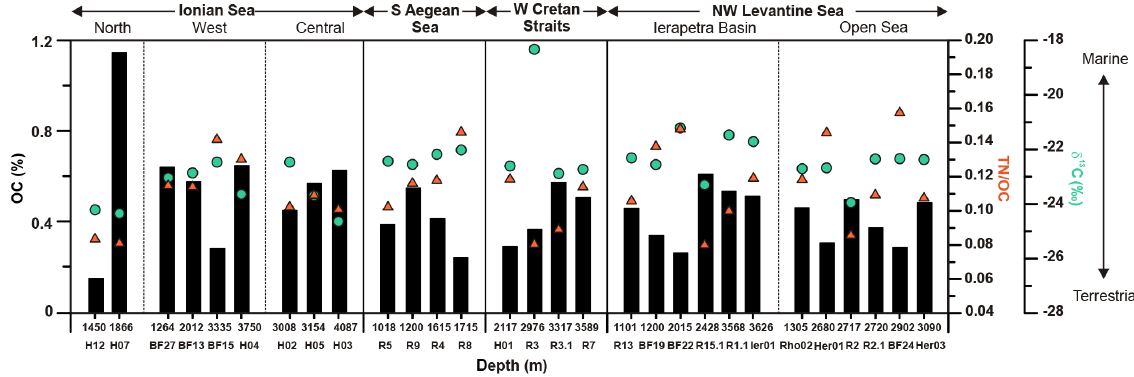
Figure 7. Distribution of OC content and bulk sediment tracers (TN / OC and δ 13 C) in surface sediments of the deep eastern Mediterranean Sea. The histogram reflects a spatially variable mixture of marine and terrestrial sources for sedimentary OM. Orange triangles and green circles correspond to molar TN / OC ratios and δ 13 C values